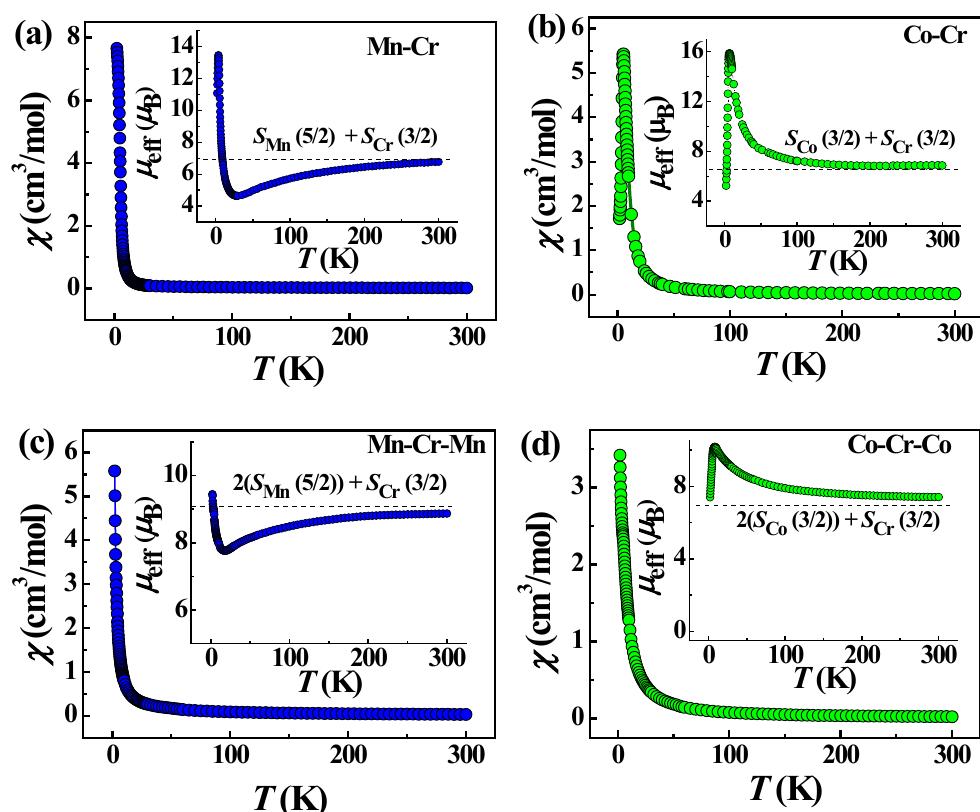
Figure 8. Temperature dependencies of magnetic susceptibility χ mol and effective magnetic moment µ eff (insets) for 1 ( a ), 2 ( b ), 3 ( c ) and 4 ( d ). The blue and green colors of the symbols distinguish the data for Mn- and Co-based complexes, respectively. The dashed lines on the insets show the estimations of effective magnetic moment for a unit cell with the Co, Cr and Mn spins, indicated on the